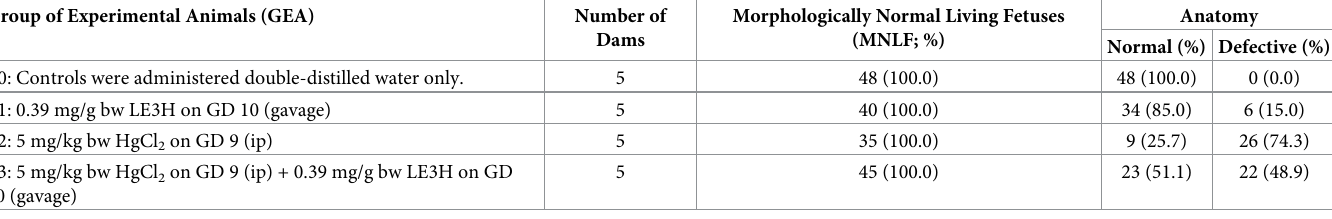
Table 1. Results of soft tissue examination using the free hand razor blade technique through eight points of fetus body in Morphological Normal Live Fetus (MNLF) of M . musculus on Gestation Day (GD) 18 which previously were given 0.39 mg/kg bw LE3H through gavage on GD10(E1), injected with 5 mg/kg bw HgCl 2 on GD9(E2), and administered 5 mg/g bw HgCl 2 on GD9 and then 0.39 mg/kg bw LE3H on GD10(E3). Meanwhile the controls (E0) were administered double-dis- tilled water only. Group of Experimental Animals (GEA)